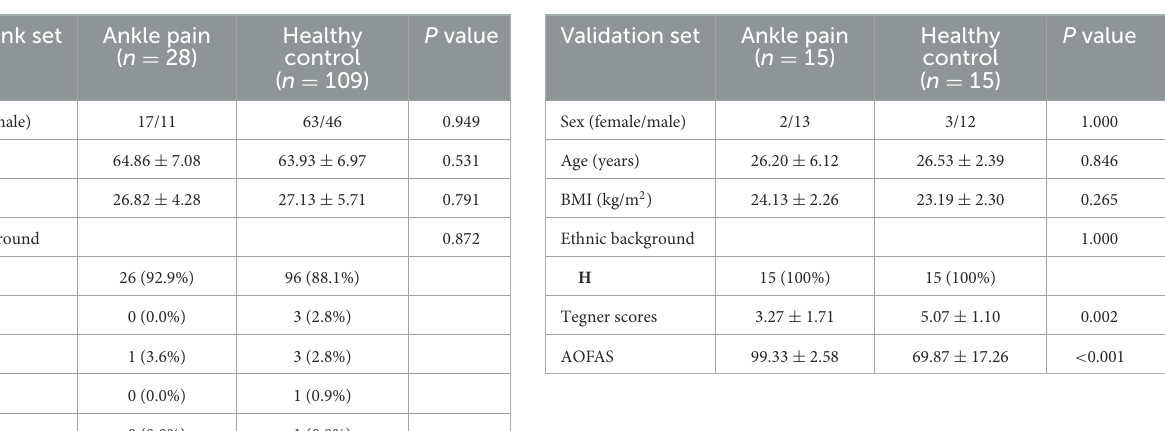
TABLE 2 Demographic variables of chronic ankle instability group and healthy control group presented as mean